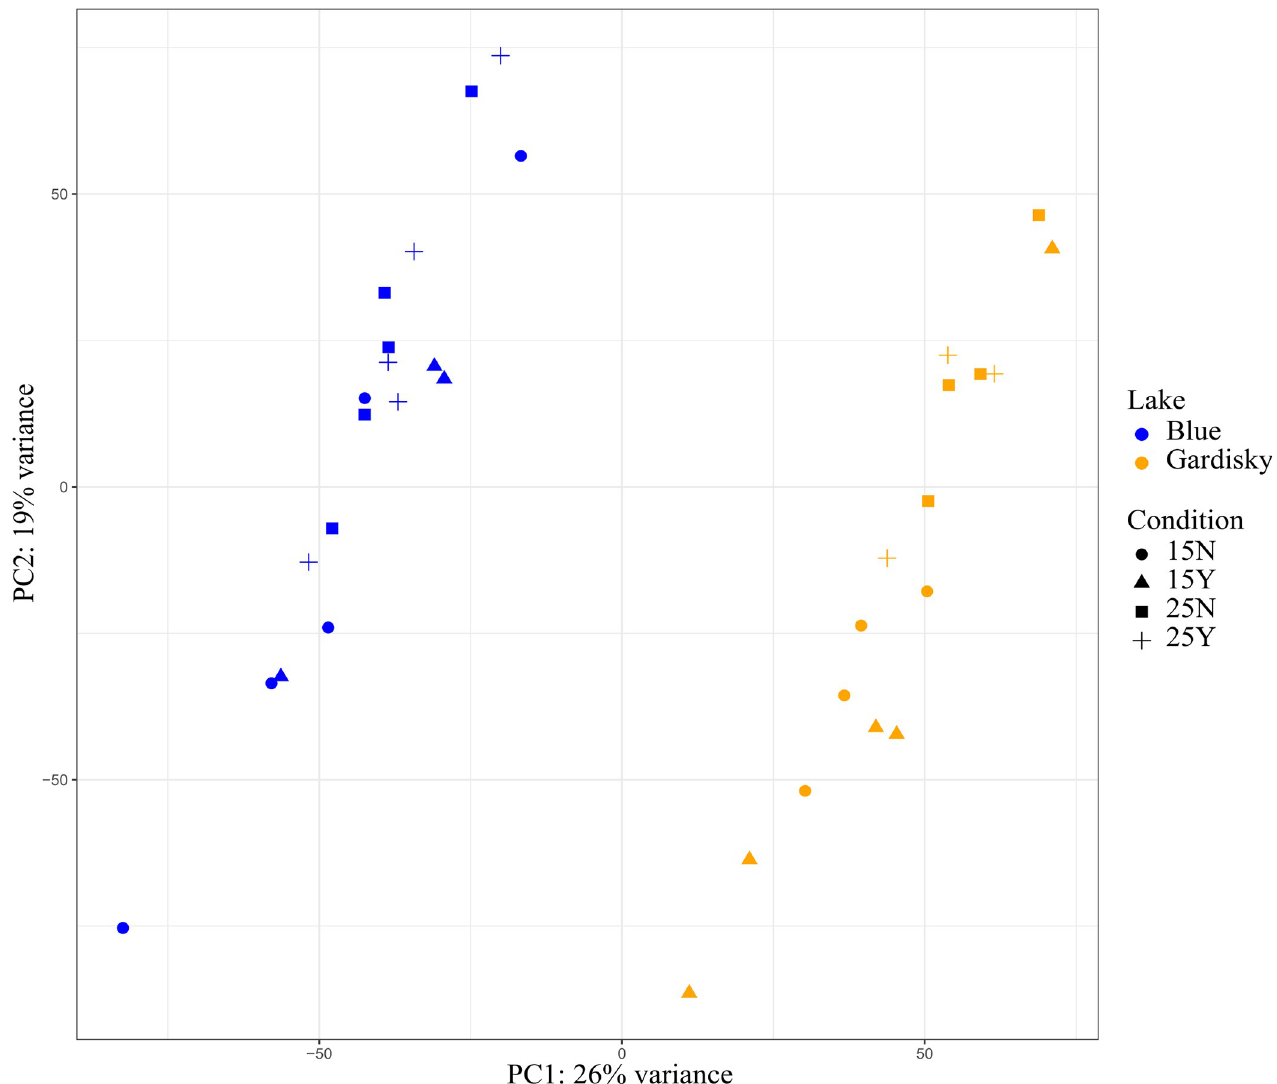
Fig 2. Genotype, not treatment group, is the dominant source of differential gene expression. Principal component analysis of gene expression patterns generated through DESeq2 prominently separates individuals by clone along the first principal component.